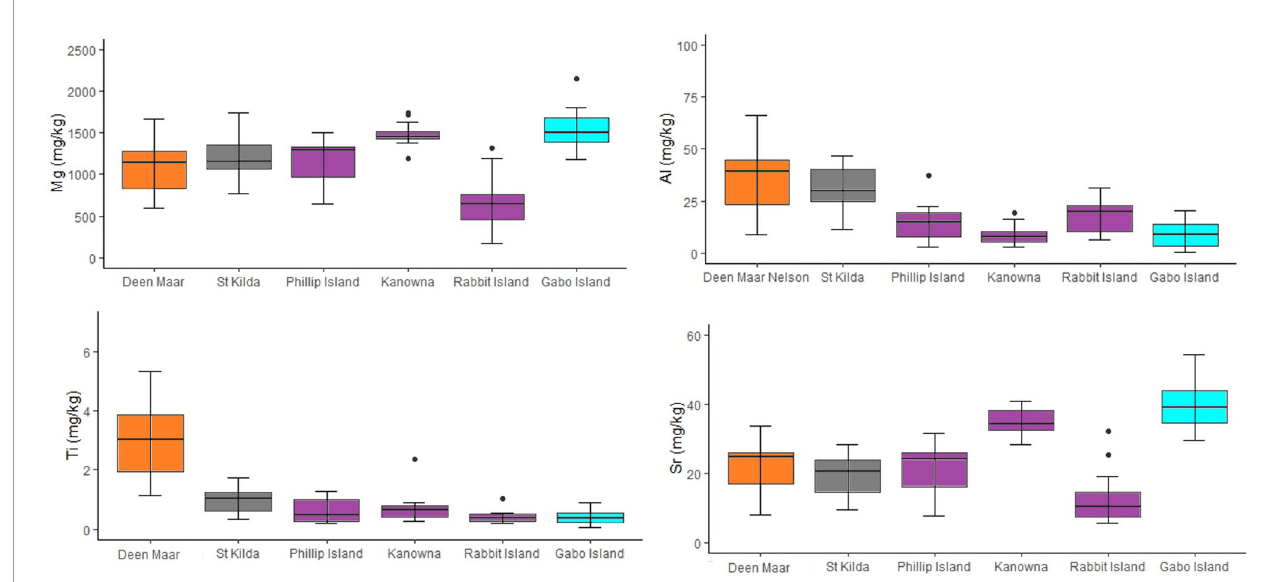
FIGURE 5 | Concentrations for trace elements Al, Ti, Mg and Sr (mg/kg dry weight) from moulted feathers of little penguins collected from Deen Maar Island and Cape Nelson (WBS), St. Kilda (PPB), Phillip Island (CBS), Kanowna Island (CBS), Rabbit Island (CBS) and Gabo Island (EBS). Box plots display median values with box edges representing lower (Q1) and upper (Q3) quartiles, de fi ned as the 25th and 75th percentiles, whiskers representing variability outside the upper and lower quartiles and dots representing outliers. The Y-axis for each element differs and colors of box plots correspond to colors presented in Figure 1